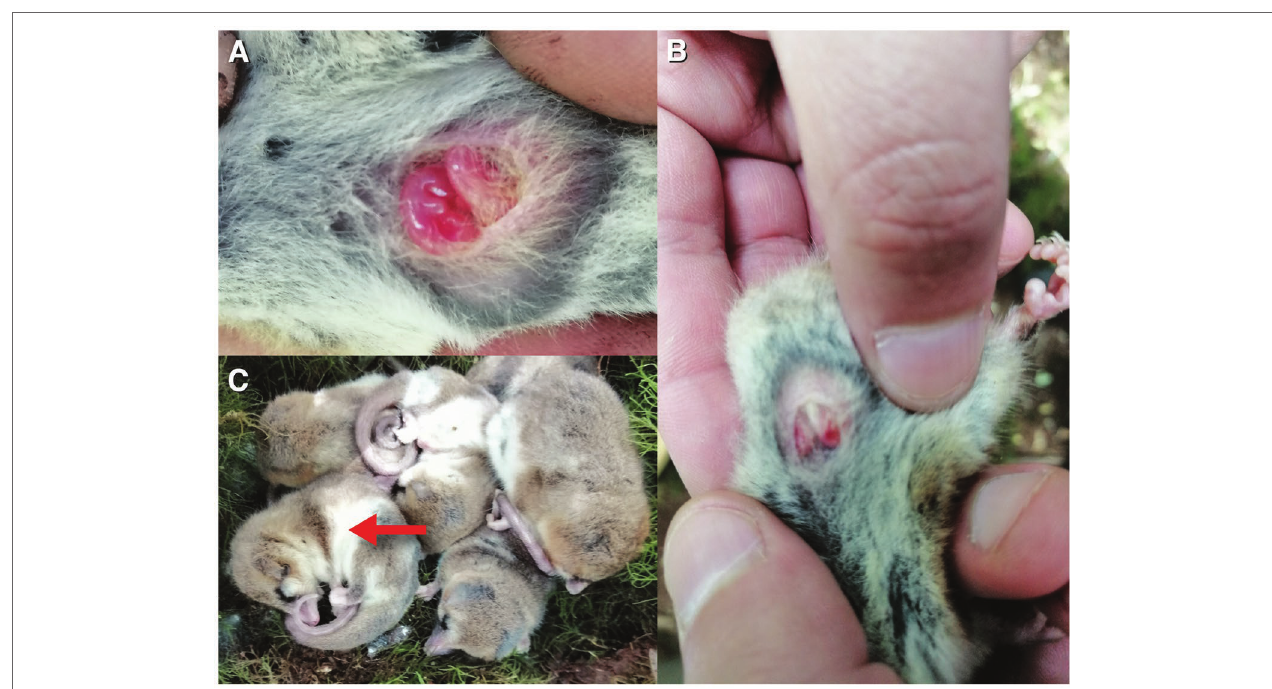
FIGURE 2 | (A) torpid pups ( n = 2, approximate age: 3 weeks) found in a torpid female ( M B = 25 g) on December 18, 2020, in the field, with T A = 25 ° C and T B of the female = 25.1 ° C. Pups were not moving. (B) shows another view, and (C) shows the cluster of torpid individuals found this day (red arrow denotes the examined female). All these animals were found active the next day.